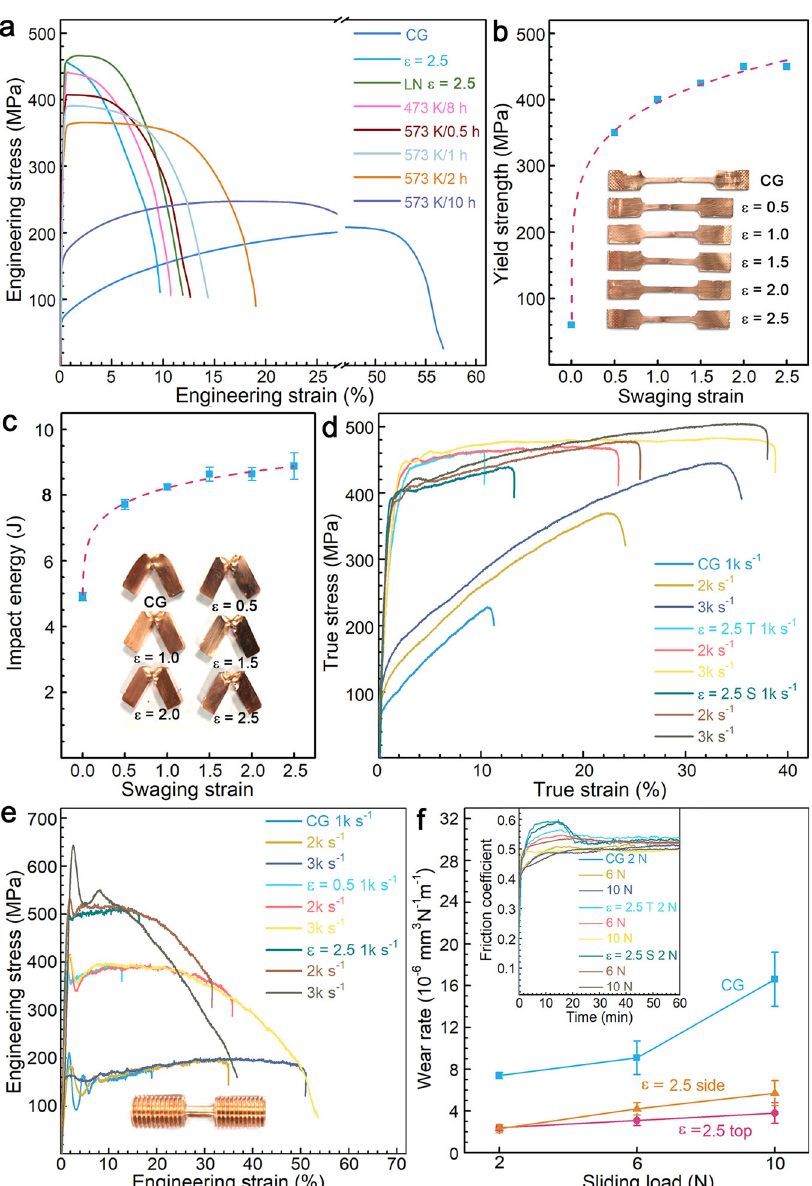
Fig. 3 Mechanical properties of the swaged copper in the center. a Quasi-static tensile curves of the swaged and CG copper tested at room and liquid nitrogen (LN) temperatures. b Yield strength versus swaging deformation stain. The insets are tensile fractured specimens. c Charpy absorbed impact energy vs swaging strain. The insets are fractured specimens (the error bar represents the standard deviation of impact energy). d Dynamic compressive curves with strain rates of 1000 – 3000 s − 1 loaded from top (T) and side (S), respectively. e Dynamic tensile curves with strain rates of 1000 – 3000 s − 1 loaded from top. f Wear rate and curves versus different sliding loads at room temperature loaded from top (T) and side (S). The inset is friction coef fi cient versus wearing time (the error bar represents the standard deviation of wear